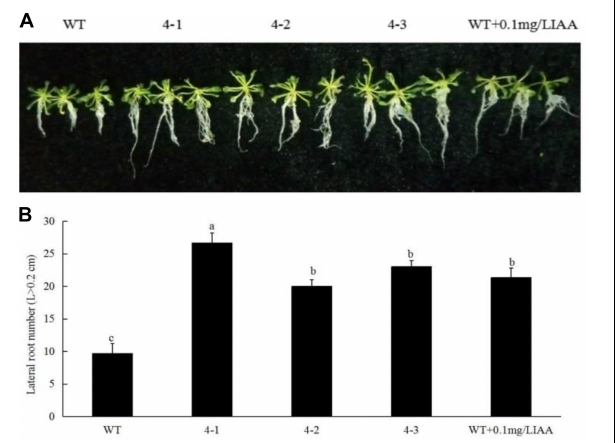
FIGURE 7 | Auxin-related gene expression in Arabidopsis thaliana wild-type (WT) and PpSnRK1 α -overexpressing (4-1, 4-2, and 4-3) plants. Error bars represent the averages of three biological replicates ± SD. Different letters represent differences between different lines in each gene. Significance was defined at P < 0.05.